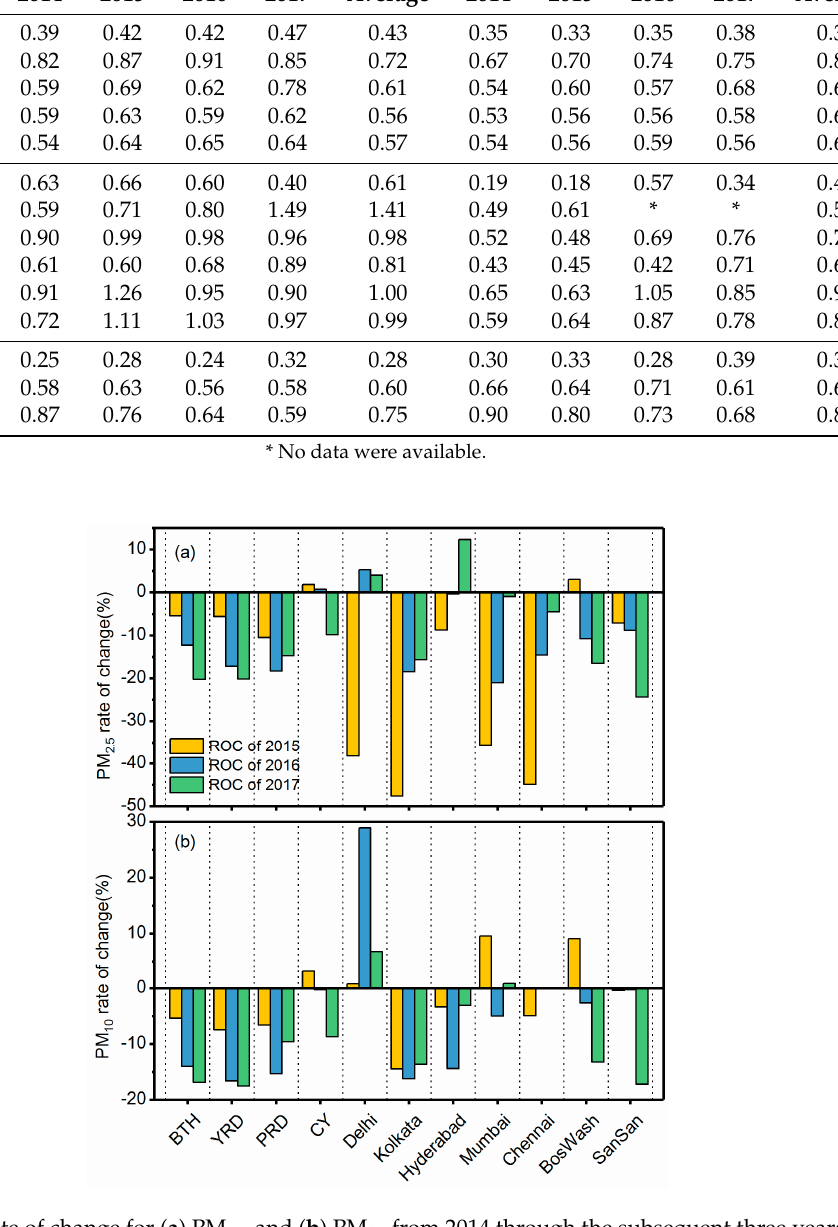
Table 3. Coefficients of variation (CV) of PM 10 and PM 2.5 in China, India, and the U.S.